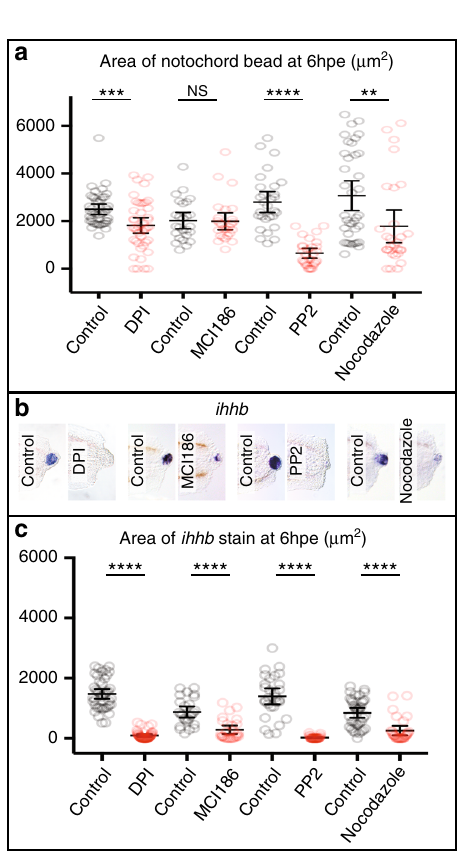
Fig. 6 DPI, MCI186, PP2 and nocodazole affect notochord bead extrusion and ihhb expression. a Bead extrusion is affected strongly by PP2 treatment and not by MCI186 treatment. DPI and nocodozole have intermediate effects on extrusion (DMSO n = 42, DPI n = 43, number of experiments =